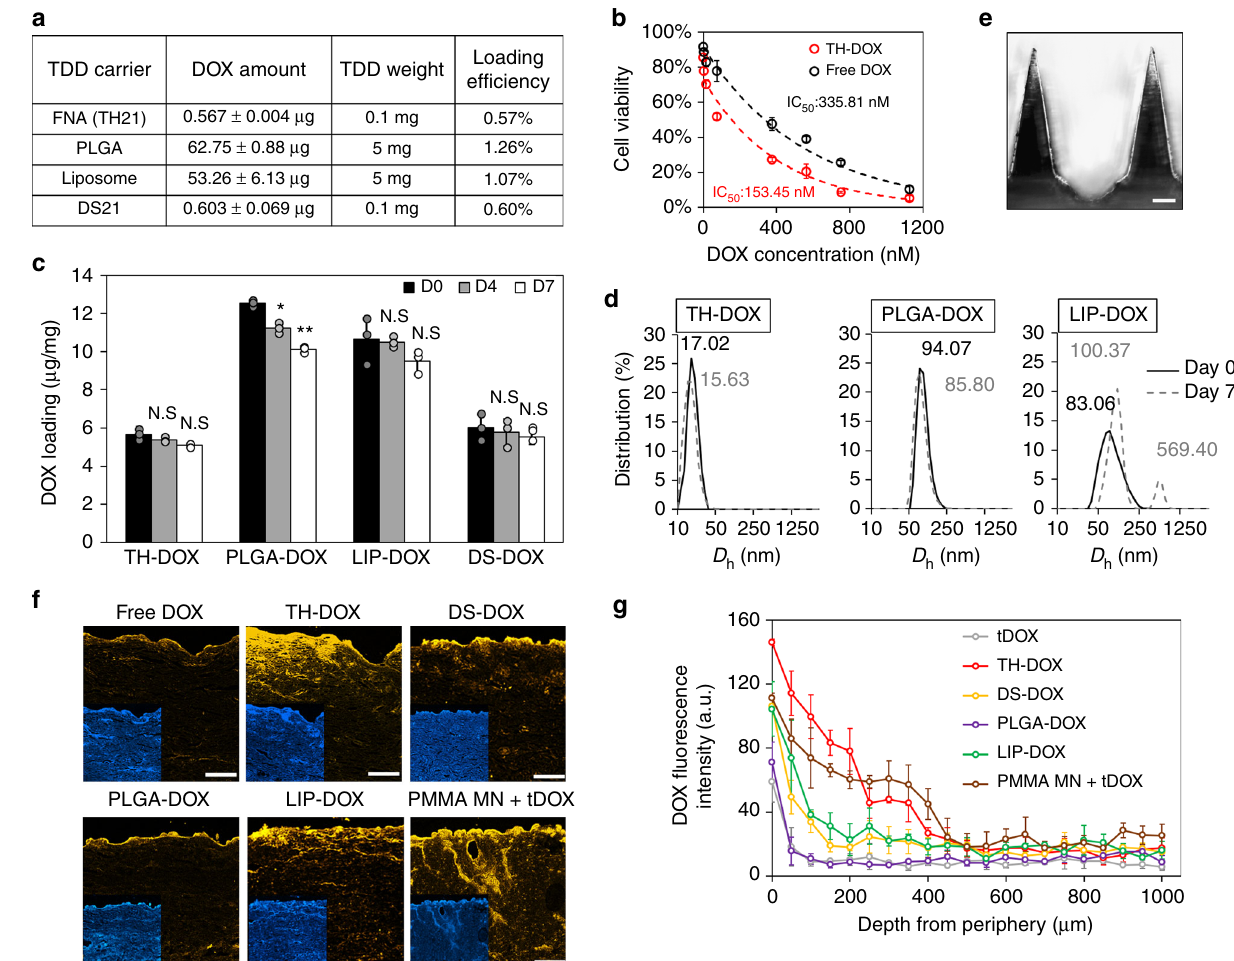
Fig. 4 Assessing FNA as transdermal drug delivery carrier: a Doxorubicin (DOX) loading ef fi ciency of FNA, 21 bp dsDNA segments (DS21), PLGA NP and liposomes. b Inhibitory concentration (IC50) assay of TH-DOX (red) and free DOX (black) after 72 h of incubation. c Loading stability (day 0: black, day 4: gray and day 7: white) and d physical stability of TH-, DS-, PLGA-, and LIP-DOX upon storage at 4 °C. Solid lines: size distribution at day 0, dotted lines: day 7 post storage. Each dot on bar chart represents independent sample measurement. e Morphology of solid PMMA microneedle for membrane disruption as control. f Representative images and g signal quanti fi cation of DOX fl uorescence following carrier penetration in pig skin for 24 h. Yellow channel: DOX fl uorescence; inlet: Hoechst33342-stained skin. Source data are provided as a Source Data fi le. Scale bar: 200 μ m. Error bars represent standard deviation. N.S represents non-signi fi cance, * p < 0.05 and ** p < 0.01 (one-way